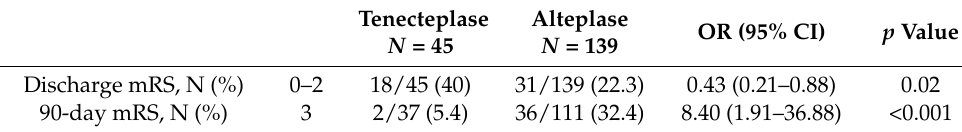
Table 2. Patient